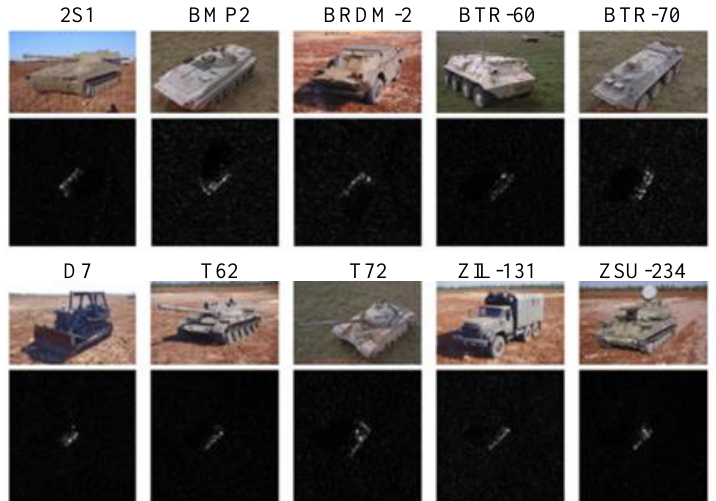
Figure 3. Optical image ( top ) and SAR image ( bottom ) of 10 types of